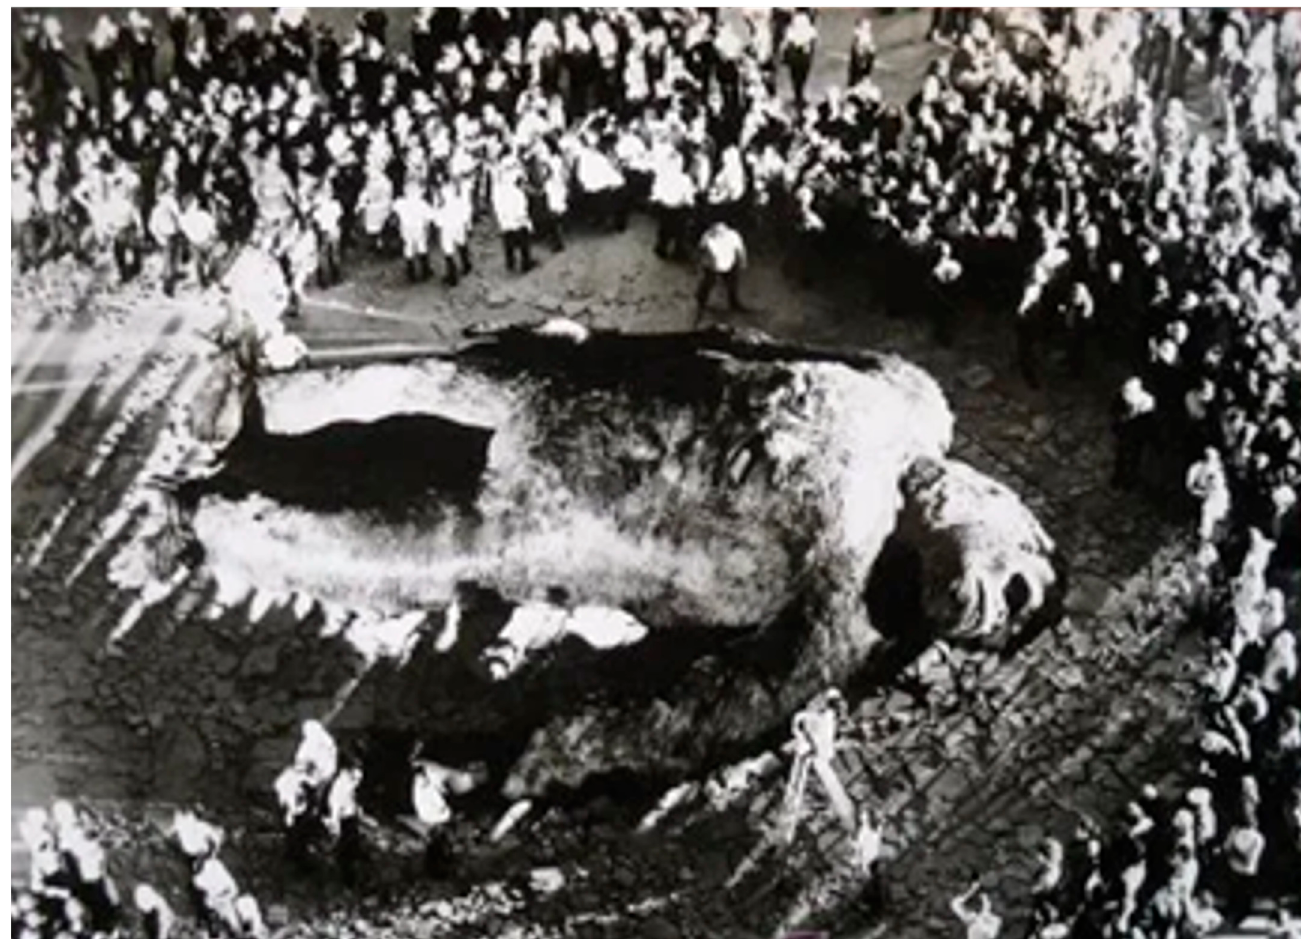
Figure 14. King Kong’s deceased body is surrounded by a crowd, forming a circle (1976). https://www.todocoleccion.net/cine-fotos-postales/king-kong-1976~x31533754 (accessed on 1 January 2021).